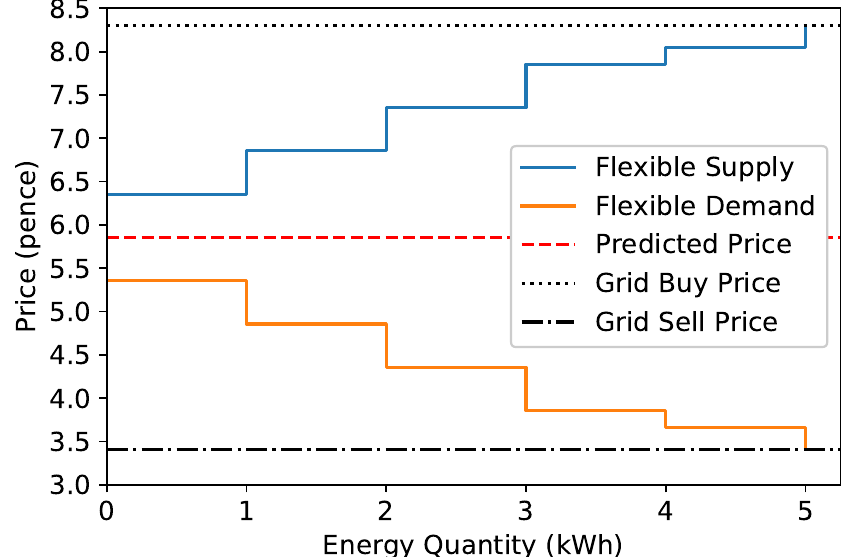
Figure 4. Asks and bids for 5 kWh of flexible energy in both supply and demand. The next round predicted price P at this instance is halfway between G T + 1 the quantity u is set to 1 kWh, the price changing rate z is set to 0.5 pence and the price distance from the grid prices y is set to 0.25 pence. This agent submitted 5 bids and 5 asks for each with 1